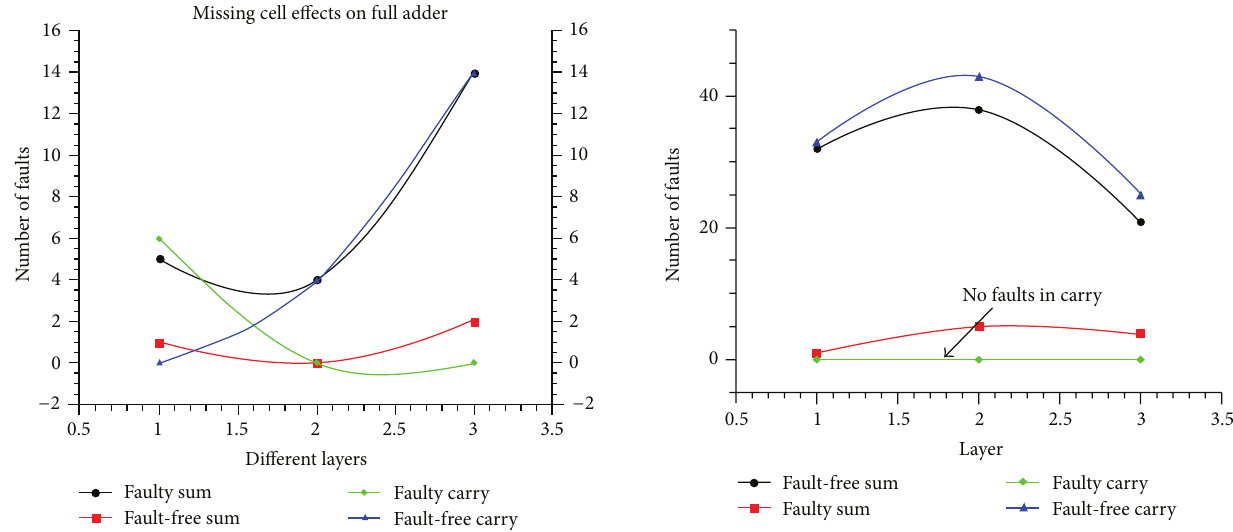
Missing cell effects on full adder